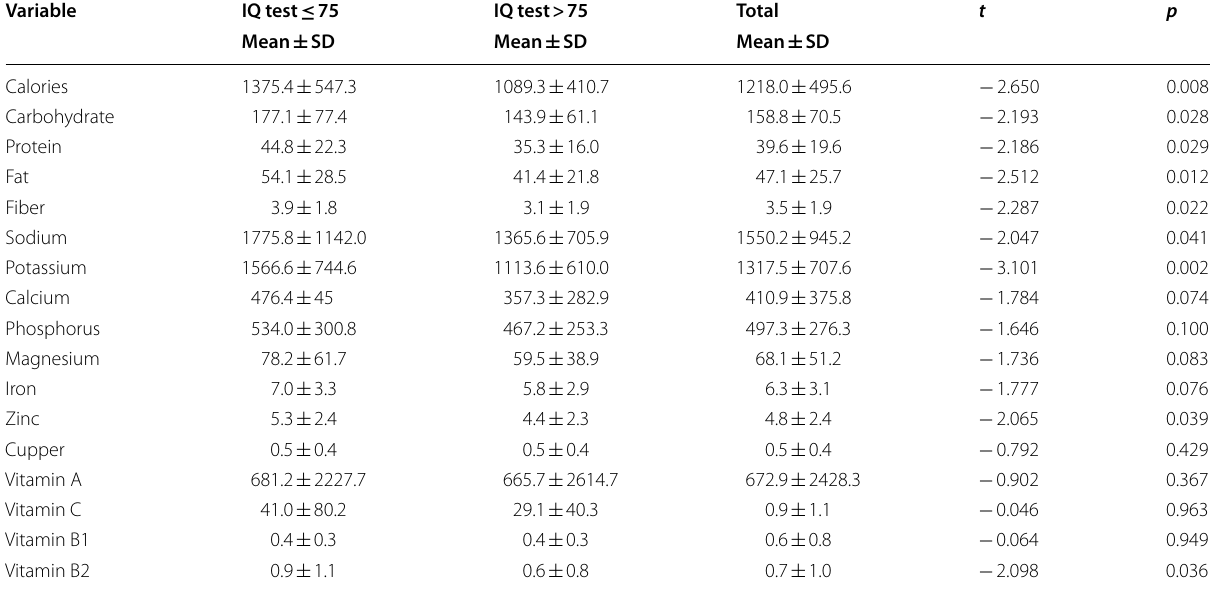
Table 6 (Mean SD) of food analysis data according to IQ test ±